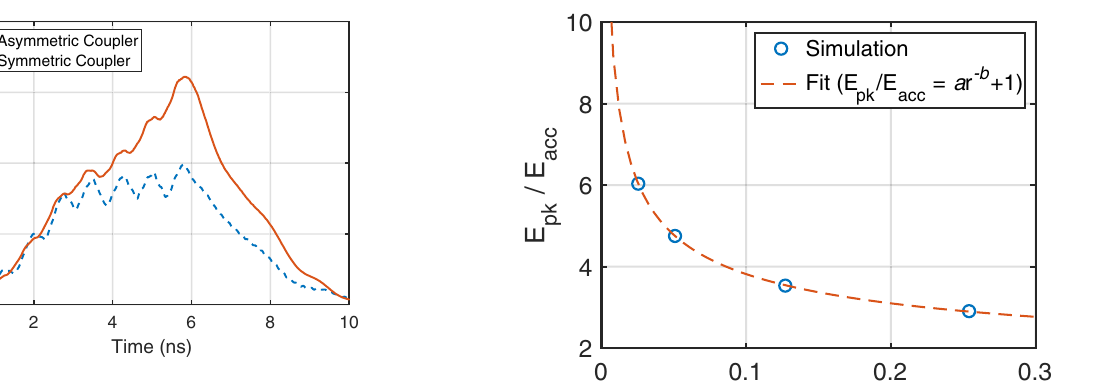
FIG. 7. The symmetric coupler design improves structure performance for a misaligned beam. For a set of 8 bunches centered 1 mm off-axis, the symmetric coupler (solid trace) produces 1.6x higher peak power and 1.4x more pulse energy than the asymmetric coupler design (dashed trace) by helping maintain linear bunch